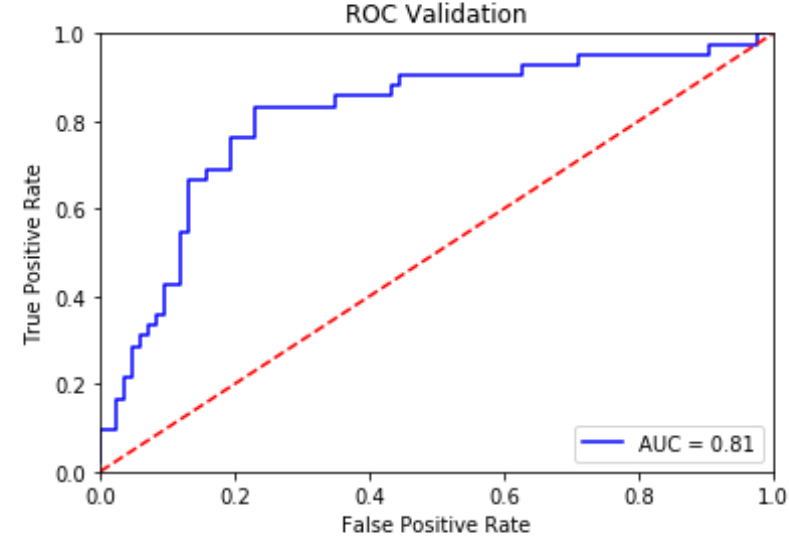
Figure 3. The receiver operating characteristic curve of E-SVM. AUC: area under the curve; ROC: receiver operating characteristic.